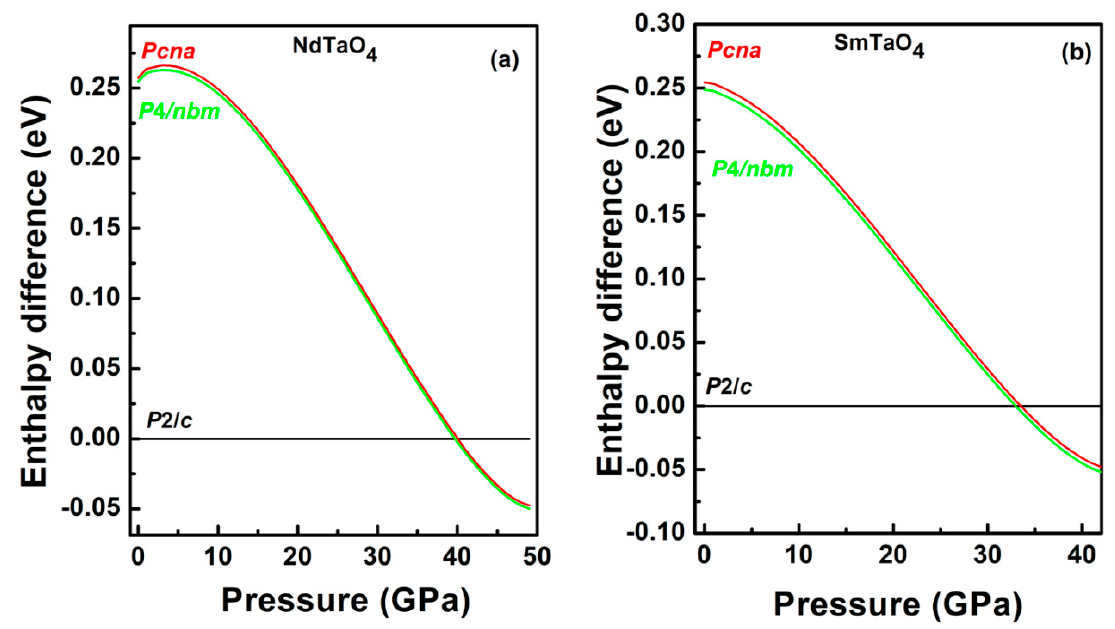
Figure 5. Enthalpy difference (eV) versus pressure for ( a ) NdTaO 4 and ( b ) SmTaO 4 . The ambient pressure monoclinic P 2/ c phase (black) has been taken as a reference for the both compounds. Red and green lines correspond to the Pcna (orthorhombic) and P 4/ nbm (tetragonal) structures, respectively.